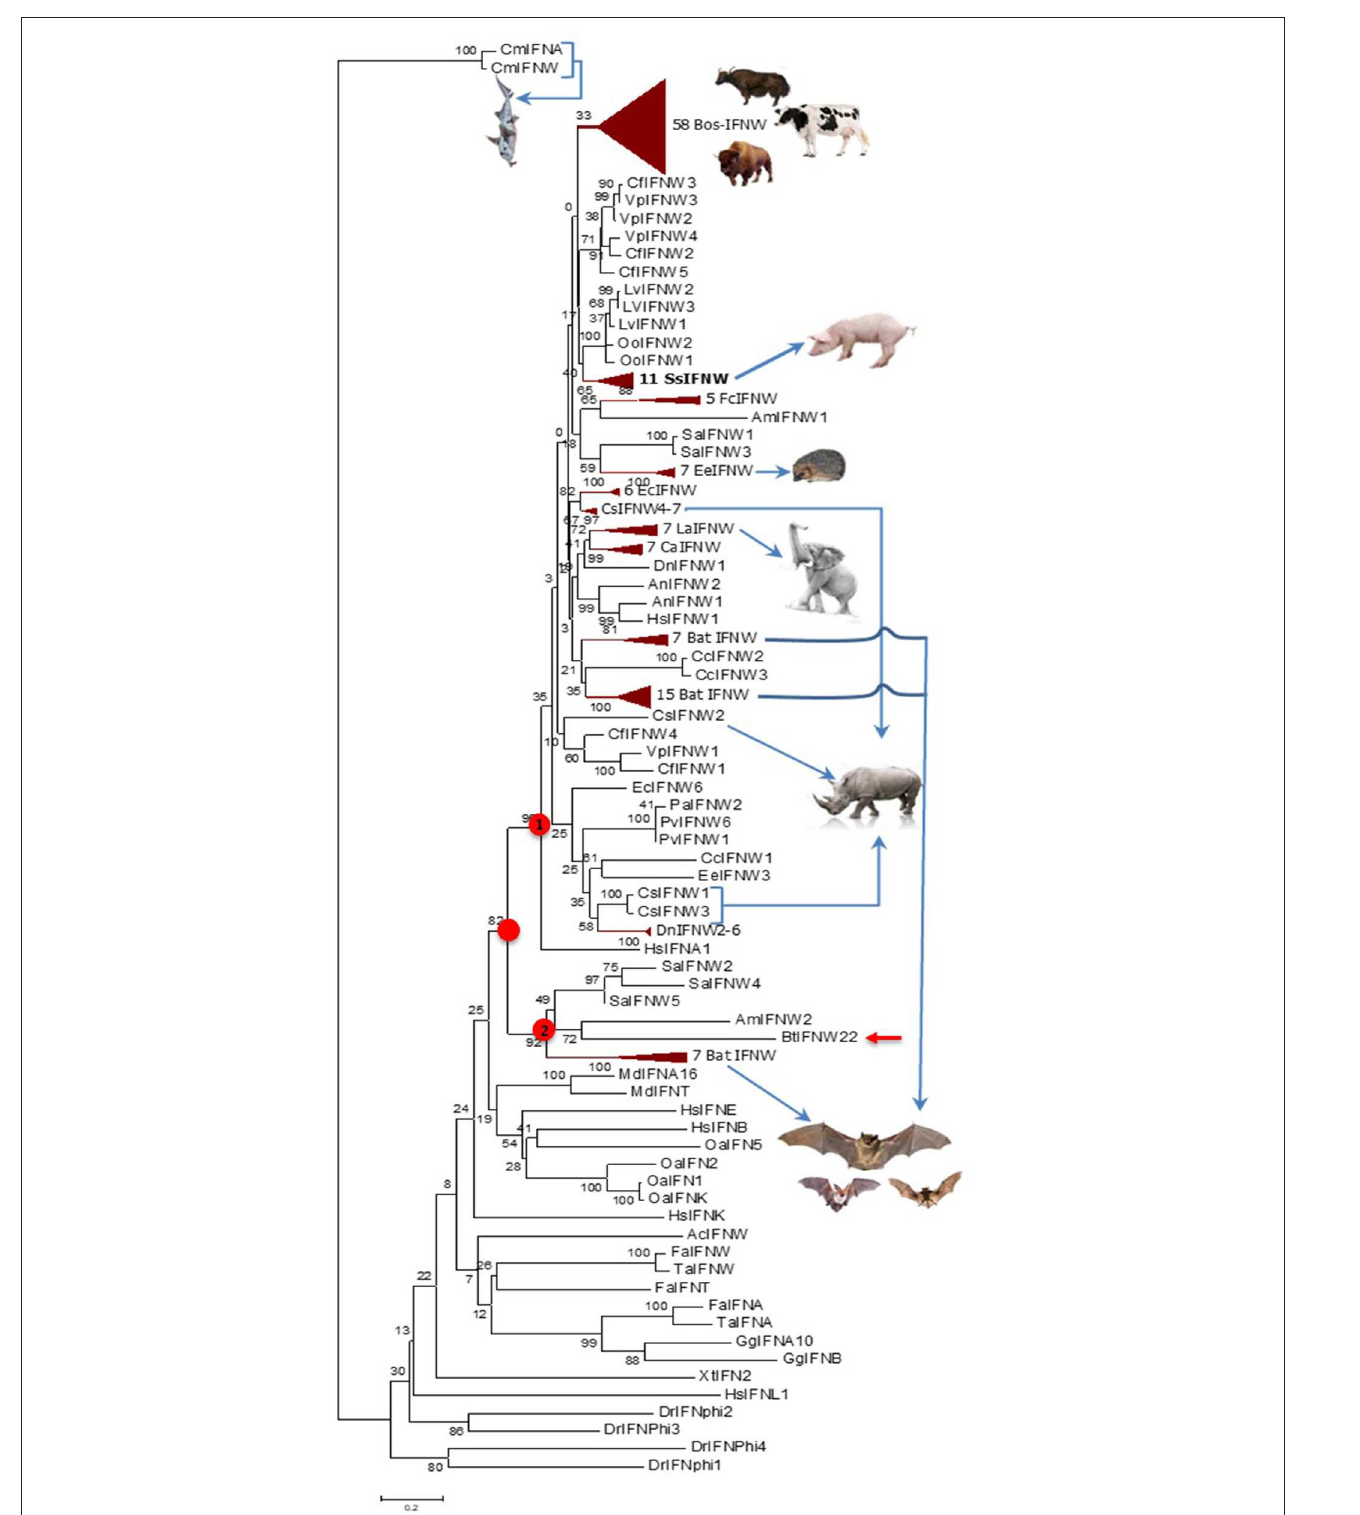
FIGURE 2 | Evolutionary relationships of the IFN- ω orthologs in different animal species/lineage, and comparison with homologs from zebrafish (DrIFNs), Xenopus (XtIFNs), chicken (GgIFNs), and humans (HsIFNs). The evolutionary history was inferred using the Neighbor-Joining method. Percentage of replicate trees in which the